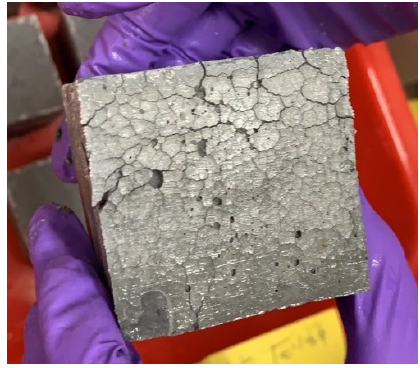
Figure 2. Appearance of the cracked specimen.